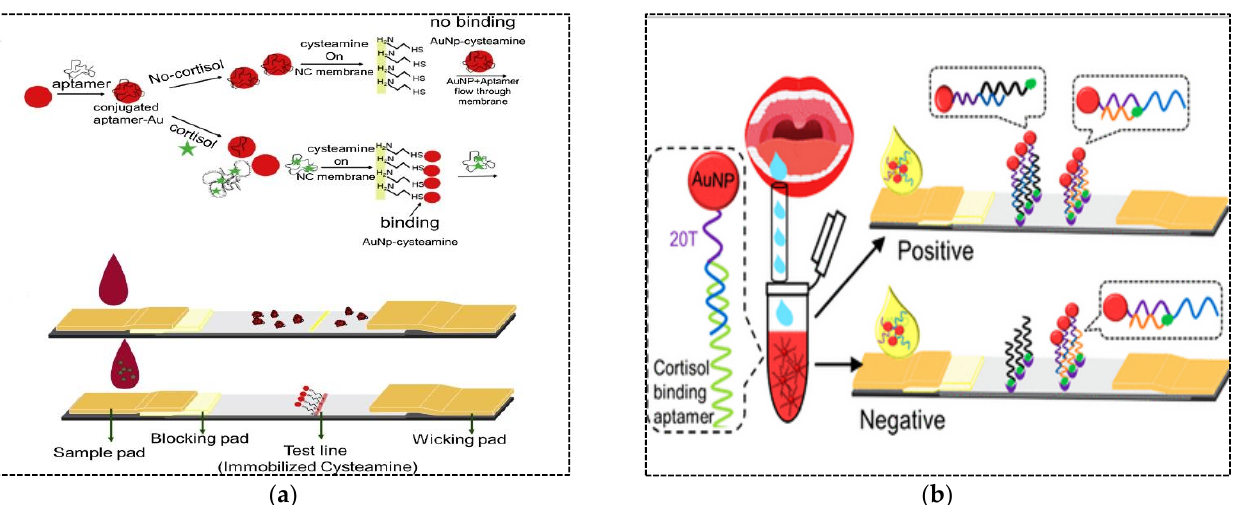
Figure 5. ( a ) A LFA based on adsorption–desorption of an aptamer on the surface of AuNPs for cortisol detection; ( b ) A LFA based on AuNPs conjugated with a duplex aptamer for the detection of cortisol in saliva. Reproduced from [56,57], respectively, with